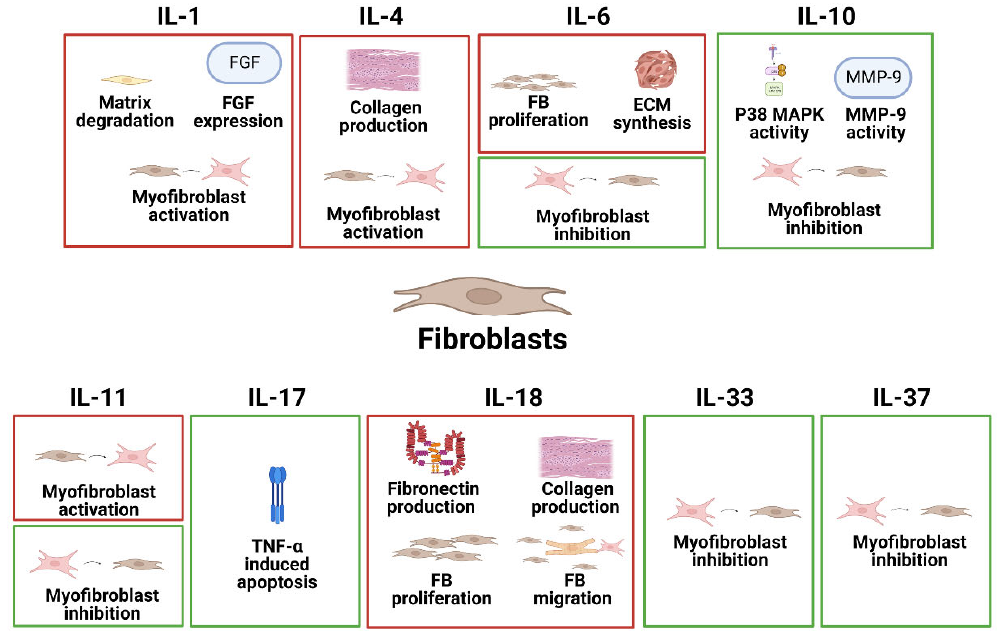
Figure 2. The specific pathophysiological effects of different interleukins on FBs in common heart disease. The box in red represents the deleterious role, and the box in green represents the protective role.